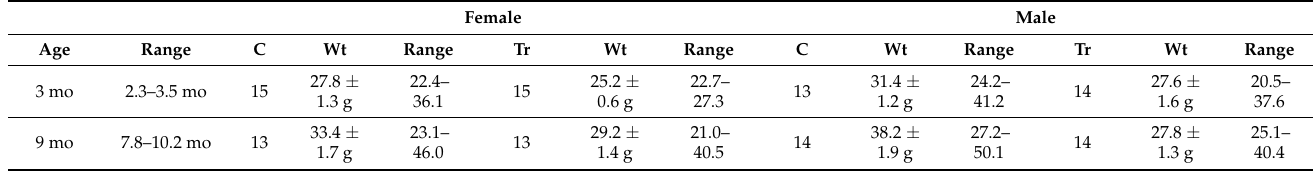
Table 1. Numbers and weights of mice in each genotype/sex